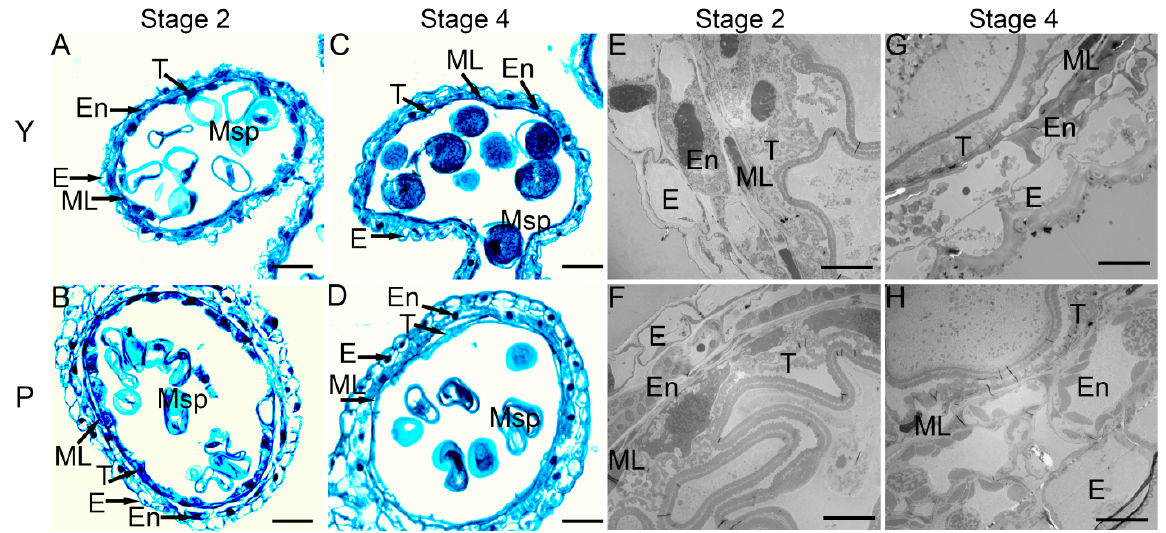
Figure 3. Observation of transverse sections ( A – D ) and transmission electron microscope (TEM) ( E – H ) of different stages in male sterile line (P) and its maintainer line (Y). ( A – D ), stained with safranin O ‐ fast green. Stage 2 (Early uninucleate stage): ( A , B , E , F ); Stage 4 (Binucleate stage): ( C , D , G , H ). E, En, ML, T, and Msp indicate the epidermis, the endothecium, the middle layer, the tapetum, and the microspore, respectively. Bars: 50 μ m ( A – D ); 10 μ m ( E – H ).